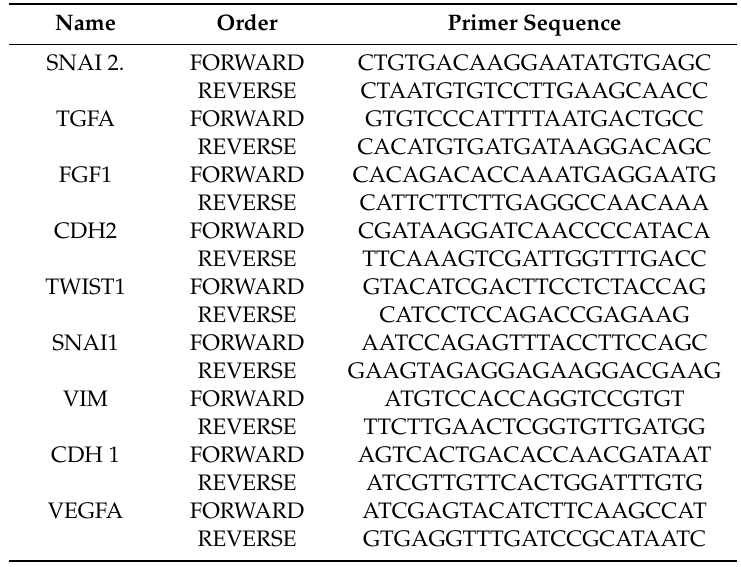
Table 1. Primers used for reverse transcriptase polymerase chain